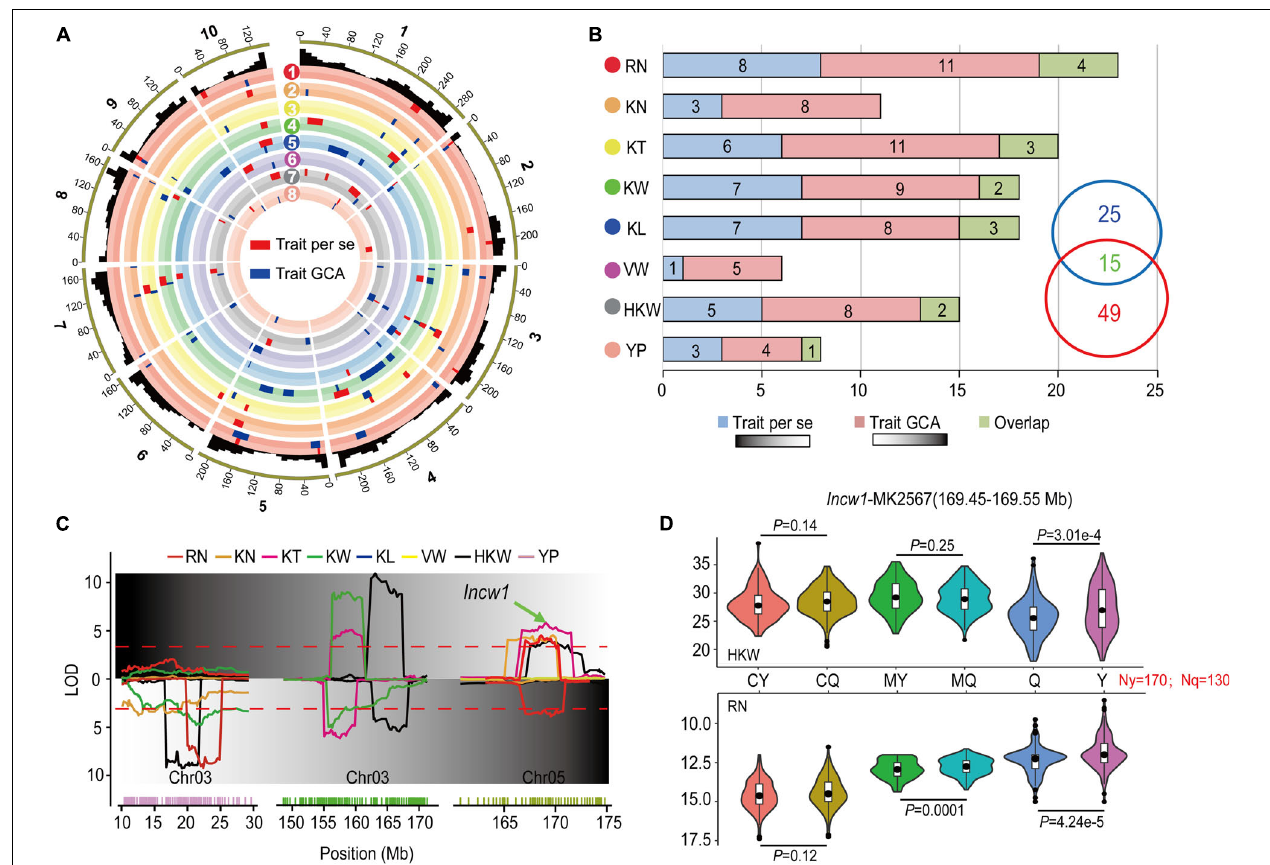
FIGURE 3 | Comparison of the QTL distributions associated with per se performances and their GCA effects for eight yield-related traits. (A) Integrated QTL on the 10 maize chromosomes for eight yield-related traits across multiple environments and the joint analyses. RN ( red ), Row number; KN ( orange ), Kernel number per row; KT ( yellow ), Kernel thickness; KW ( green ), Kernel width; KL ( blue ), Kernel length; VW ( purple ), Volume weight; HKW ( gray ), 100-kernel weight; YP ( pink ), Yield per plot. The red and blue boxes indicate the QTL results in per se performances and their GCA effects for the traits, respectively. The width of the boxes reflects the length of the confidence intervals for each QTL. (B) QTL numbers distributed on each dataset for eight yield-related traits across multiple environments and joint analyses. Green boxes show the number of QTL overlapping between per se performances and their GCA effects for the traits. (C) A typical pleiotropic locus on chromosomes 3 and 5. The x -axis indicates the genetic positions across the maize genome in Mb. The y -axis indicates the LOD score of the detected QTL. The green arrow shows the position of Incw1 , which influences HKW. (D) Tests for differences among phenotypic values for HKW and RN associated with MK2567 in the parental inbred lines, Ye478 and Qi319, of RILs and the corresponding hybrids obtained by crossing with testers. CY and CQ represent the phenotypic values of the hybrids of Chang7-2 × Ye478 and Chang7-2 × Qi319. MY and MQ represent phenotypic values of the hybrids of Mo17 × Ye478 and Mo17 × Qi319. Y and Q represent phenotypic values of Ye478 and Qi319. P < 0.05 represents the level of significance for differences in the performance HKW (above) and RN (below) in CY and CQ, MY and MQ, and Y and Q,